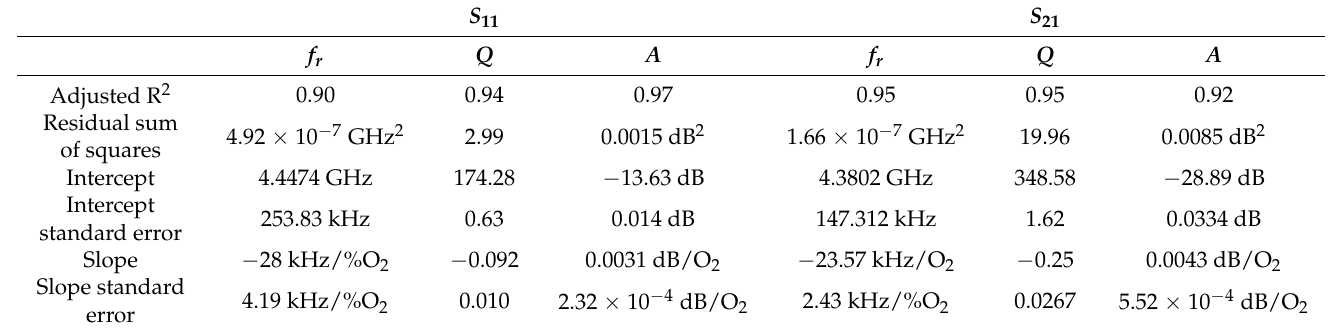
Table 1. Adjusted R 2 , residual sum of squares and coefficients (with standard errors) of the fitting carried out on the experimental measurements.